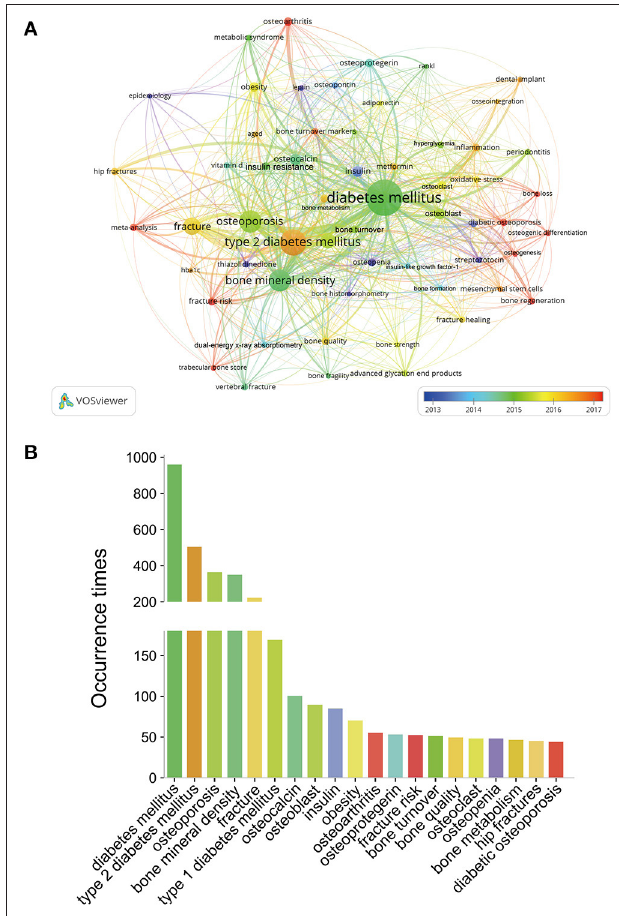
FIGURE 9 | (A) Overlay visualization map of keywords analysis in BMDM field based on the VOSviewer. The node size is proportional to the sum of occurrence times. The color of each node implies the average appearing year according to the color gradient in the lower right corner. The blue color represents the keywords appeared relatively earlier, and the dark red color reflects the recent occurrence. (B) Frequency distribution of the top 20 most frequent occurrences